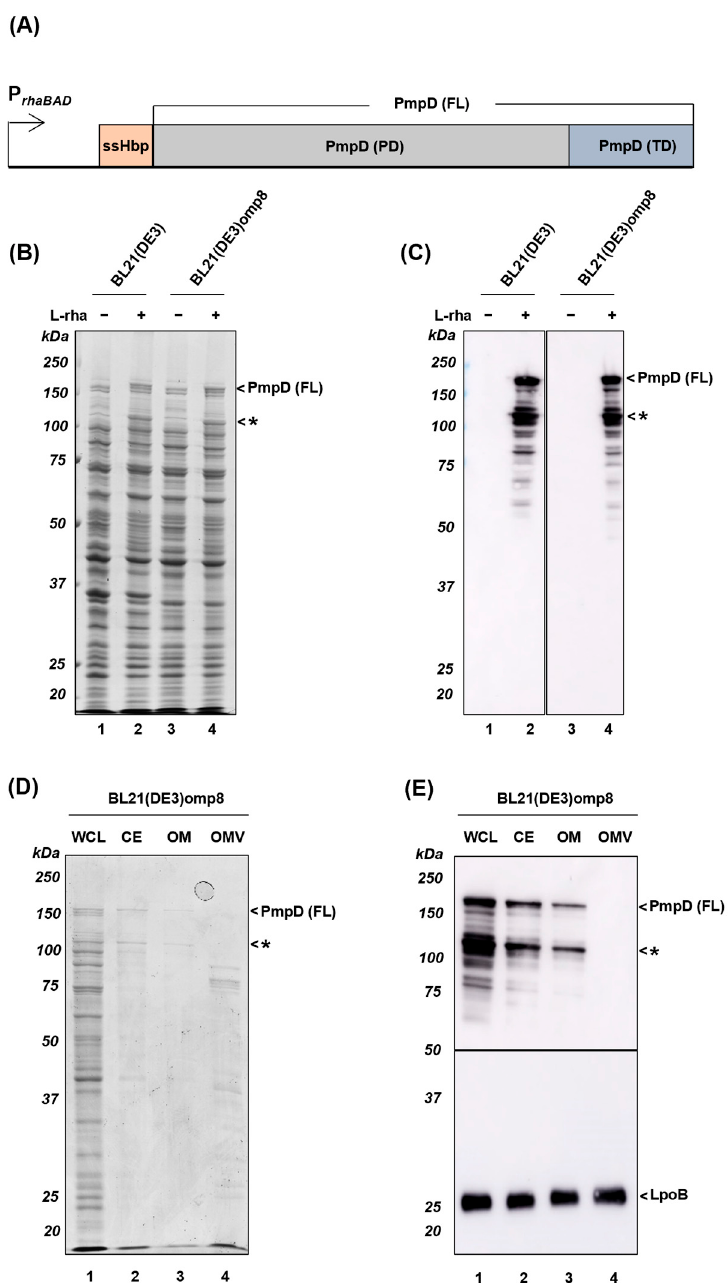
Figure 1. Expression of C. trachomatis PmpD (FL) in different E. coli strains. ( A ) Schematic representation of the pLemo-PmpD (FL) construct. E. coli Hbp signal sequence (ssHbp) fused to C. trachomatis PmpD (FL) that consists of passenger and β -barrel domain under control of the rhaBAD promoter. ( B , C ) Whole-cell lysates of E. coli BL21(DE3) and BL21(DE3)omp8 cells induced with (+) or without ( − ) 8 mM L-rhamnose for 2 h for expression of PmpD (FL) were analyzed by SDS-PAGE, followed by Coomassie staining ( B ) or immunoblotting using PmpD antiserum ( C ). ( D , E ) A cellular subfractionation of BL21(DE3)omp8 cells expressing PmpD (FL) resulted in whole-cell lysate (WCL), cell envelope (CE) and outer membrane (OM) fractions. BL21(DE3)omp8 outer membrane vesicles (OMV) were collected from the filtered culture supernatant. Samples derived from 0.05 OD 600 units of WCL, CE, OM, as well as the equivalent 4 OD 600 units of E. coli OMVs were analyzed by SDS-PAGE followed by Coomassie staining ( D ) and immunoblotting against PmpD or LpoB antisera as indicated. In the panels ( B – E ), the proteolytic product of PmpD (FL) of ~120 kDa was annotated (*). MW markers (in kDa) are indicated at the left and identified protein bands at the right side of panels.